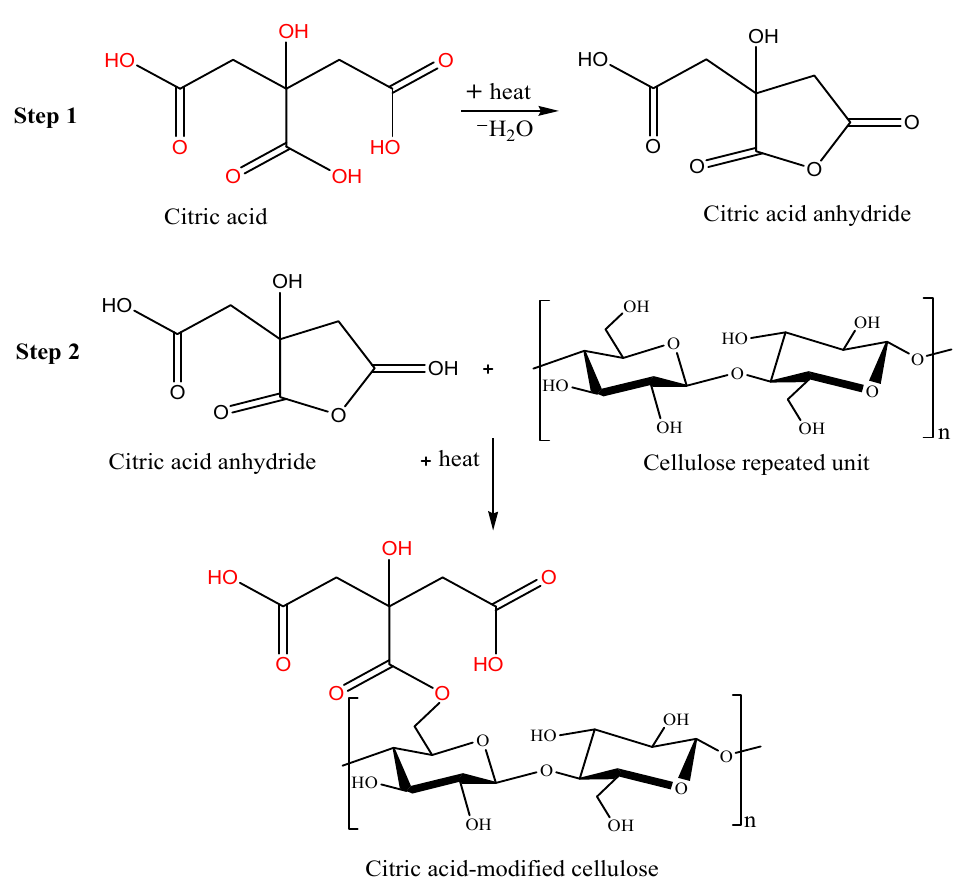
Figure 2. Reaction sequence of modified cellulose derived from Moringa peregrina with citric acid.